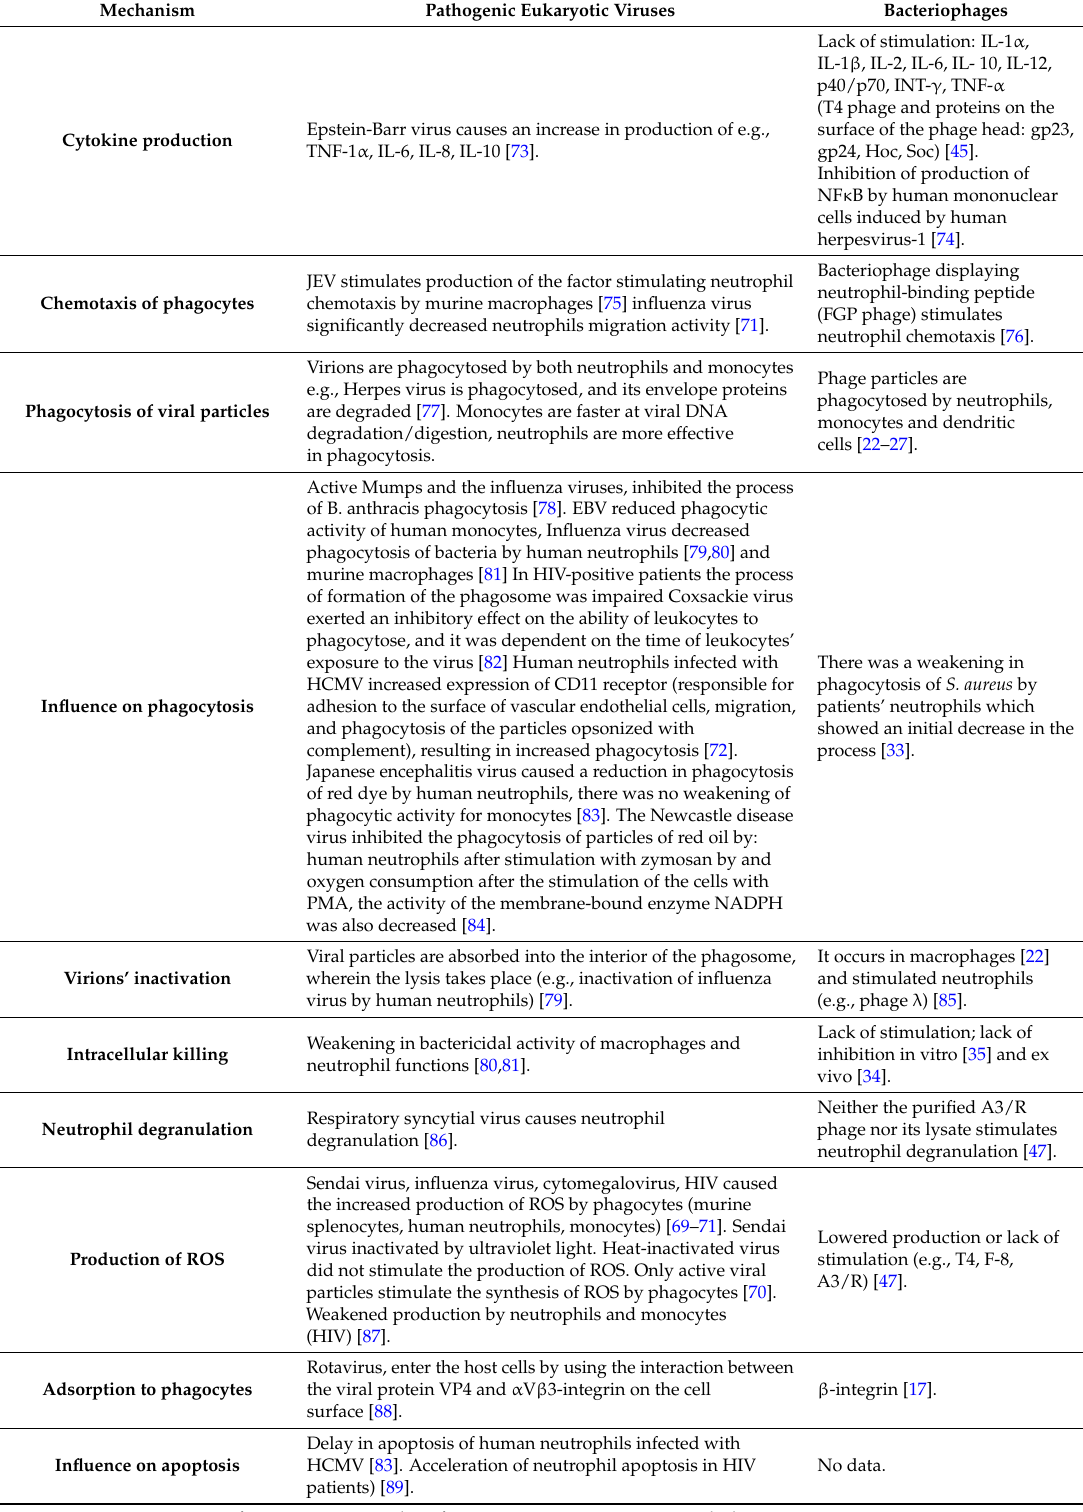
Table 1. The influence of pathogenic and nonpathogenic (phages) viruses on phagocyte